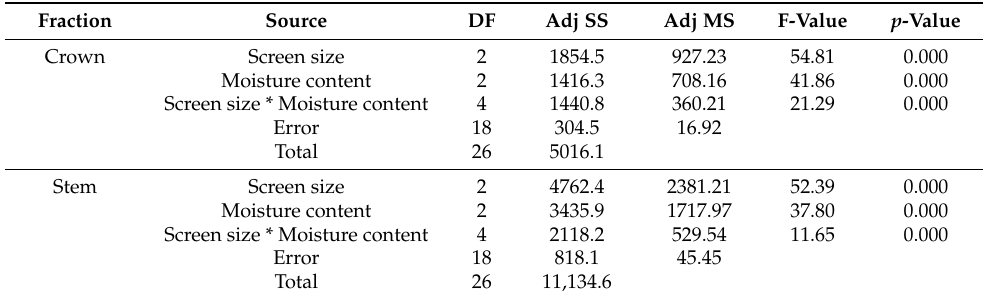
Table 7. ANOVA effects of screen size and moisture content on shatter index of crown and stem fractions of the briquette ( p < 0.05).